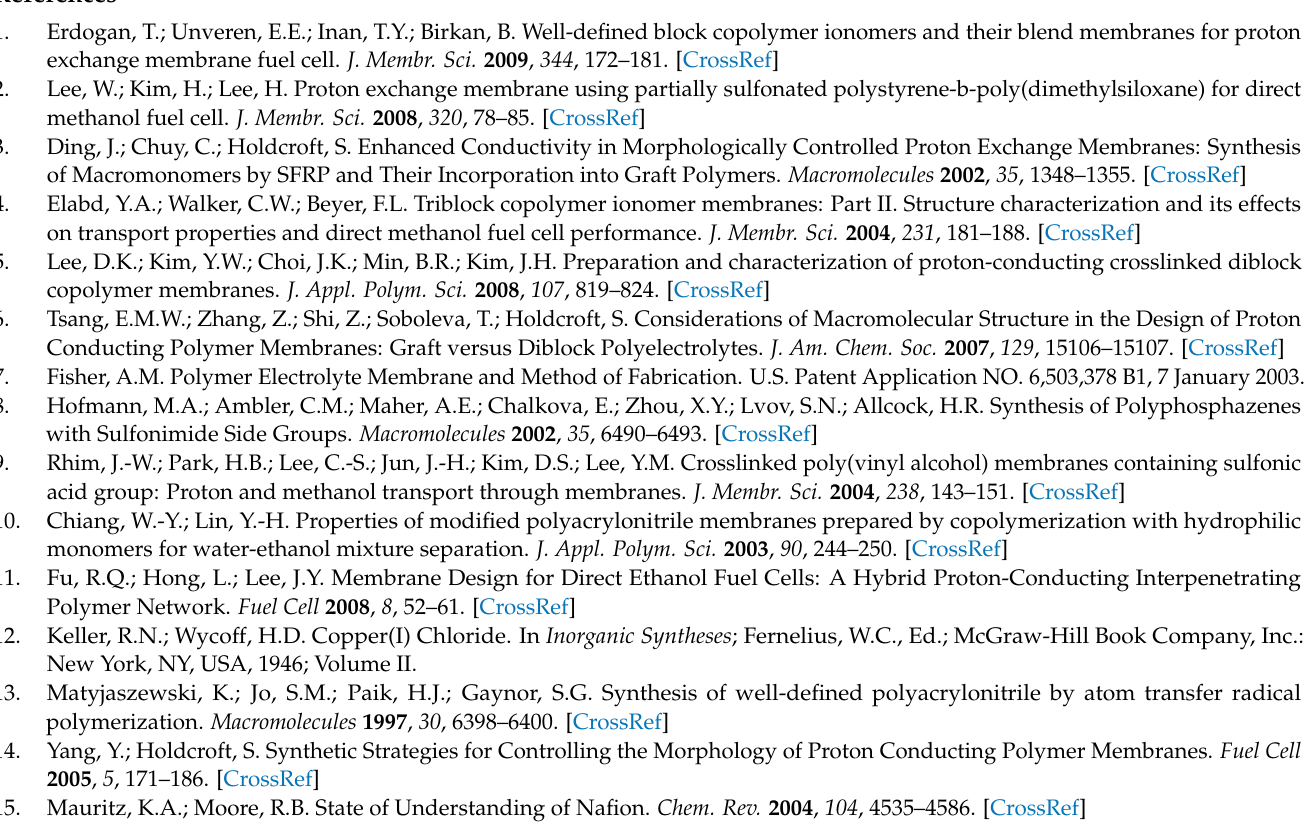
Figure A6. FE-SEM images of cross-linked diblock A150G4S-10 membrane (magnification 100,000×).